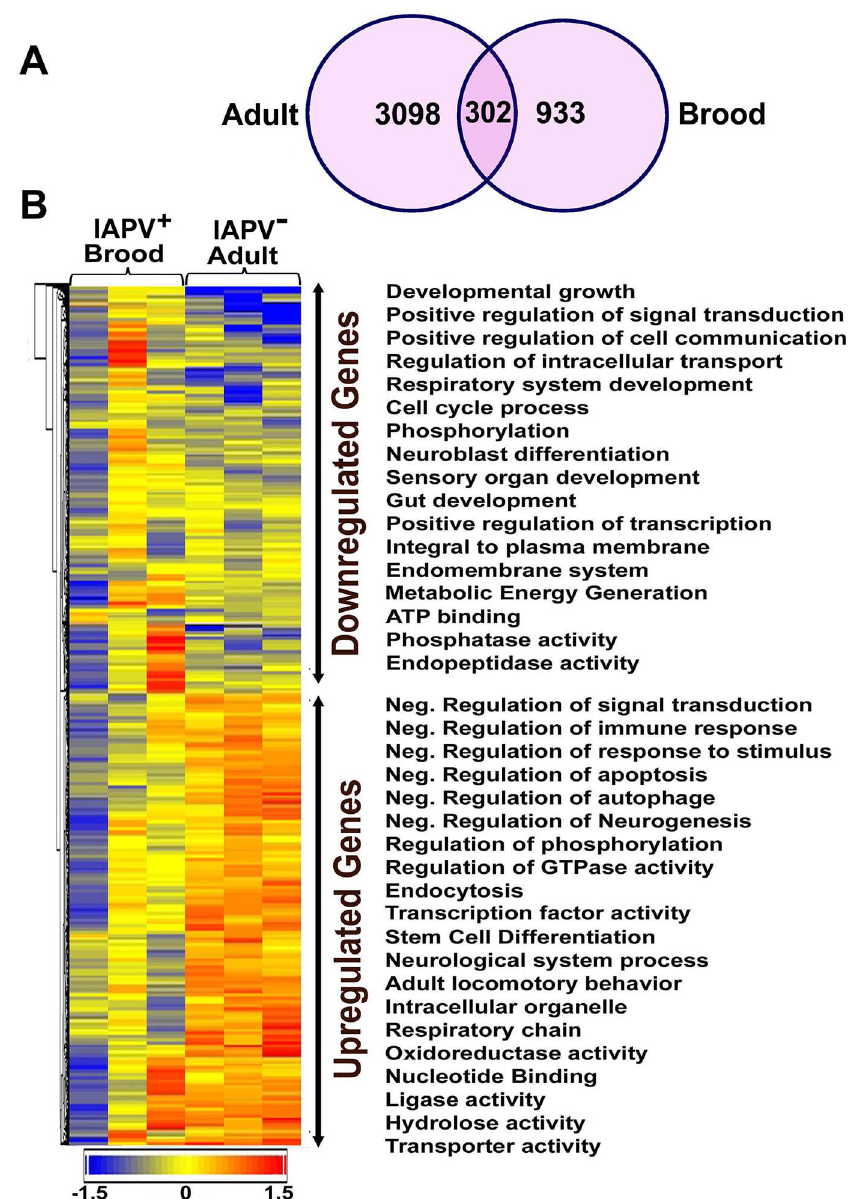
Figure 5. An overview of gene expression profiles in IAPV infected adults and brood. ( A ) Venn graph compares regulated genes between adult and brood. The intersecting circles indicate overlapping genes between adult and brood. Of 4615 genes with altered expression in IAPV- positive adult and 1350 genes with altered expression in IAPV-positive brood, the number of overlapping genes between adults and brood was 336. ( B ) A heat map illustrates differential expression profiles of up- and down- regulated genes for adults and brood. The number of genes with altered expression was significantly higher in IAPV infected adult than in IAPV infected brood. The relative levels of gene expression are depicted using a color scale where blue indicates the lowest and red indicates the highest level of expression. Significantly enriched Gene Ontology (GO) terms of up- and down regulated gene clusters inducted by IAPV infection ( r # 0.05) appear on the right side of the heat map.